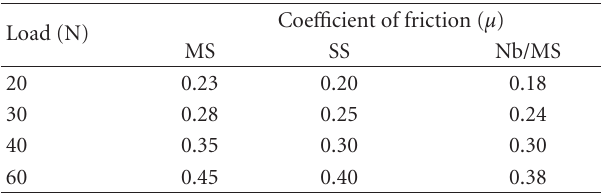
Figure 10: Scratch test for NbN coating (deposited at N 2 /Ar flow = 20%) on MS with Nb interlayer at (a) 1N, showing start of the scratch, (b) 12N, revealing segregation, cracks, and pores, (c) 22 N, displaying cracks, pores, and pile-up, and (d) 32N, showing chipping, pile-up, and partial delamination. Table 3: μ at di ff erent loads for NbN/MS, NbN/SS and NbN/Nb/ MS, during scratch